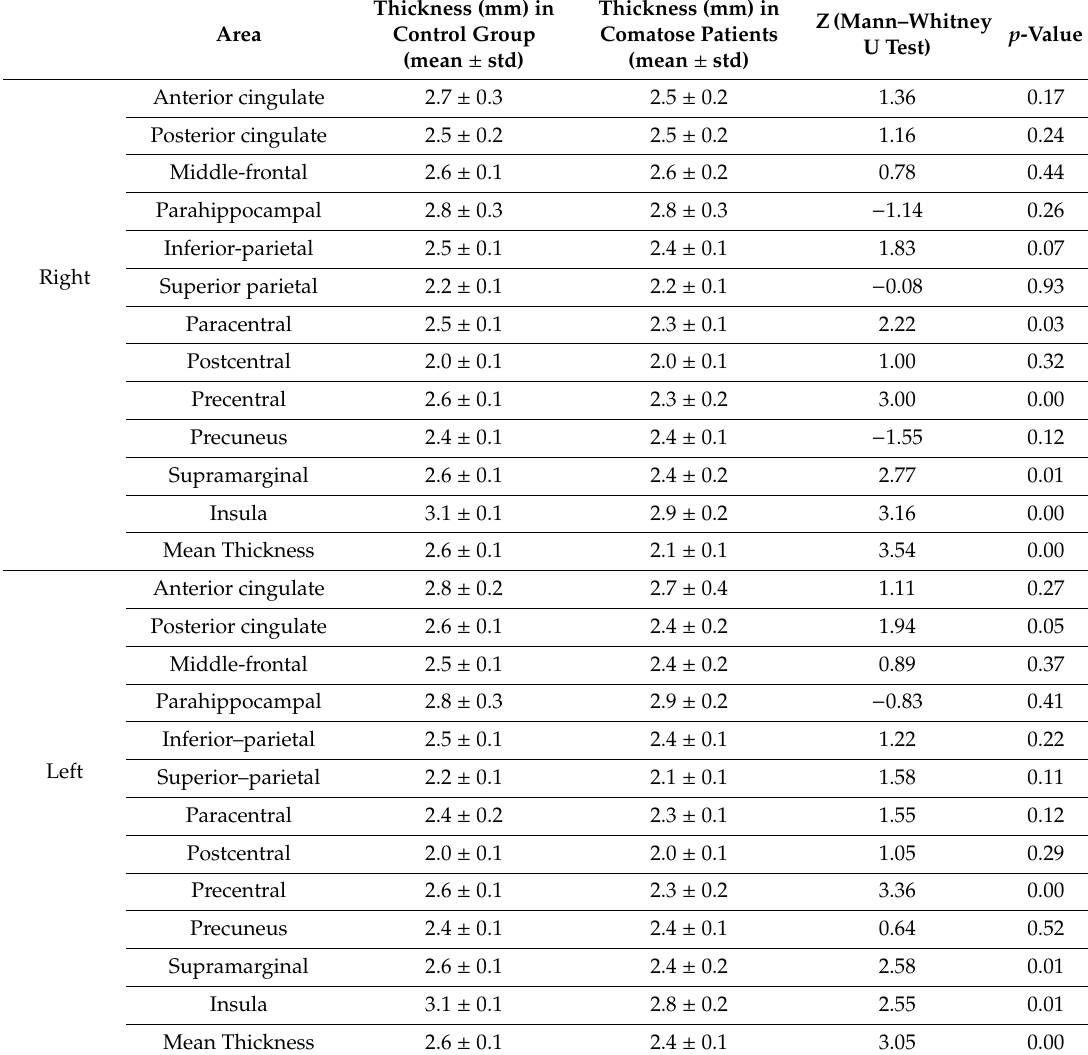
Table 2. Cortical thickness in areas associated with tactile stimulation and level of consciousness (according to literature data) and their cross-group di ff erences.